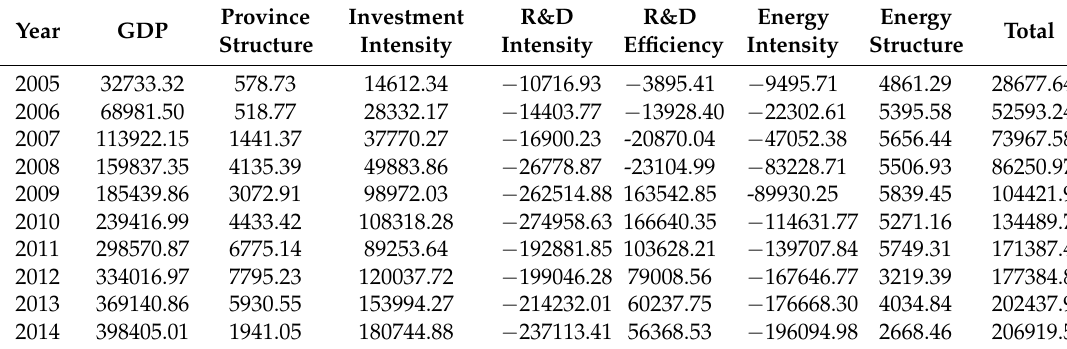
Table 7. The accumulated effects of different factors of carbon emissions from energy consumption of China in 2005–2014 (unit: 10 4 tons).